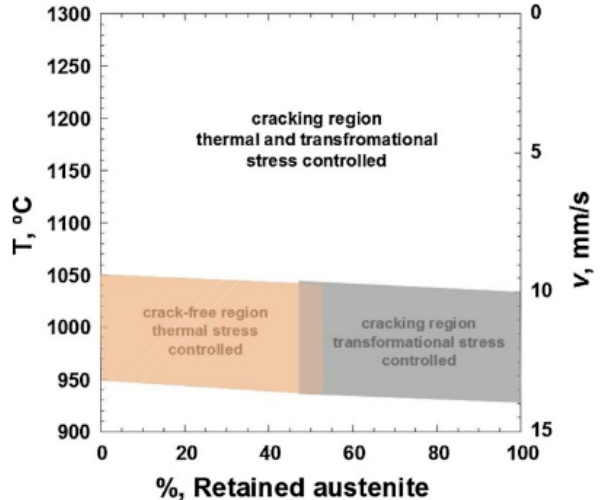
Figure 9. Laser processing window for LSH/LSM treatments as a function of retained austenite content, scanning velocity, and surface temperature (Reprinted with permission from ref. [51]. 2012 Elsevier).